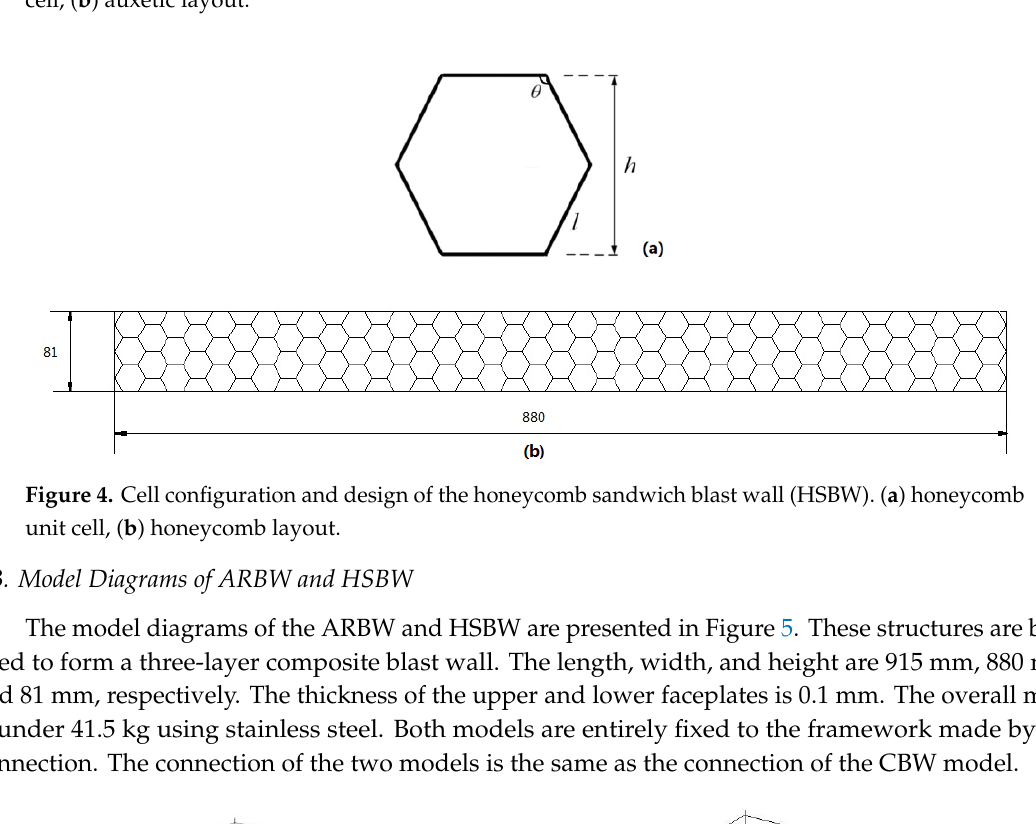
Figure 5. Model diagrams: ( a ) ARBW, ( b ) HSBW.